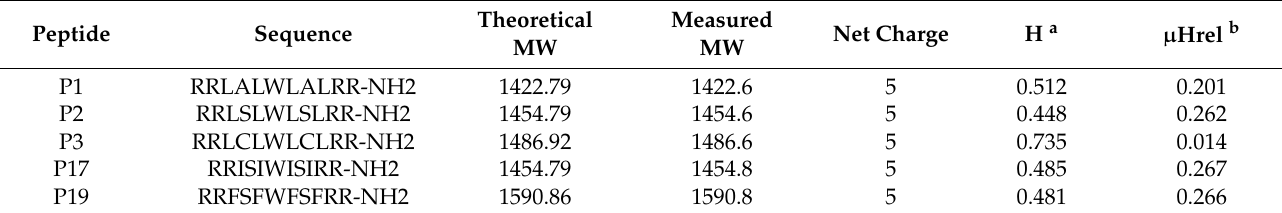
Table 1. Peptide design and their key physicochemical parameters.